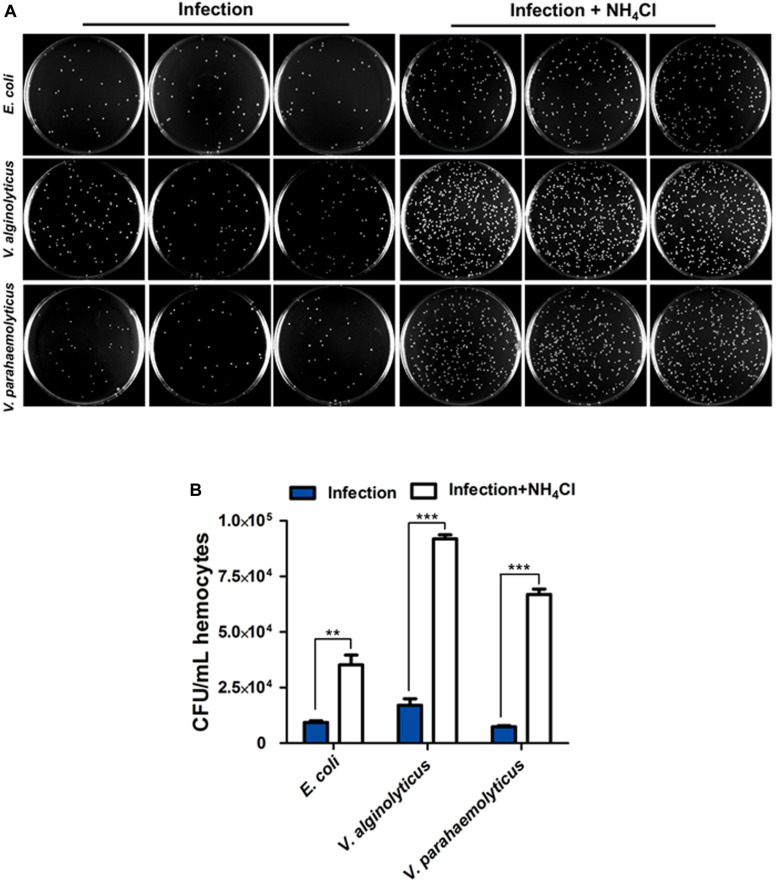
Autophagy contributes to bacteria clearance in hemocytes. (A) Representative agar plating results for infection outcomes with or without treatment of NH4Cl as an autophagy blocker. C. hongkongensis hemocytes were exposed to Escherichia coli (E. coli), Vibrio alginolyticus (V. alginolyticus) or Vibrio parahaemolyticus (V. parahaemolyticus). (B) Statistical difference in the extent of bacteria clearance the control and NH4Cl groups was determined by Student’s t-test between. Enumeration of bacterial colonies was presented as mean ± SEM (n = 3 plates), with significance being determined at **p < 0.01 and ***p < 0.001. Results are representative of three independent experiments.